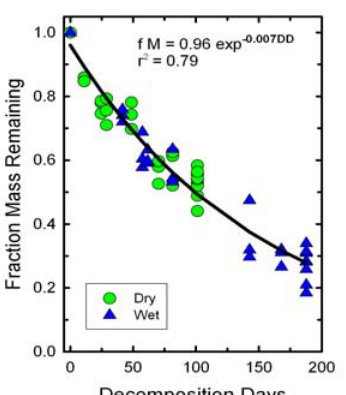
Figure 2 . Changes in initial wheat straw mass as a function of decomposition days (DD). A single exponential decay function fit both dry and wet